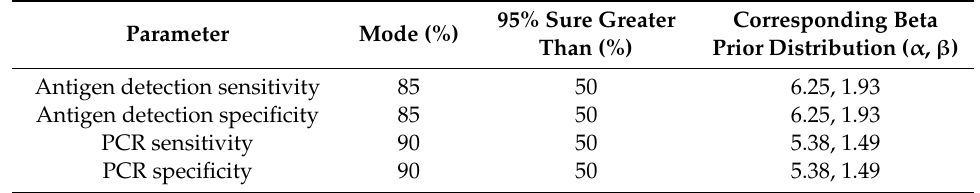
Table 1. Informative beta priors used for estimation of test sensitivity (Se) and specificity (Sp) of antigen detection and conventional PCR in study population in a Bayesian latent class